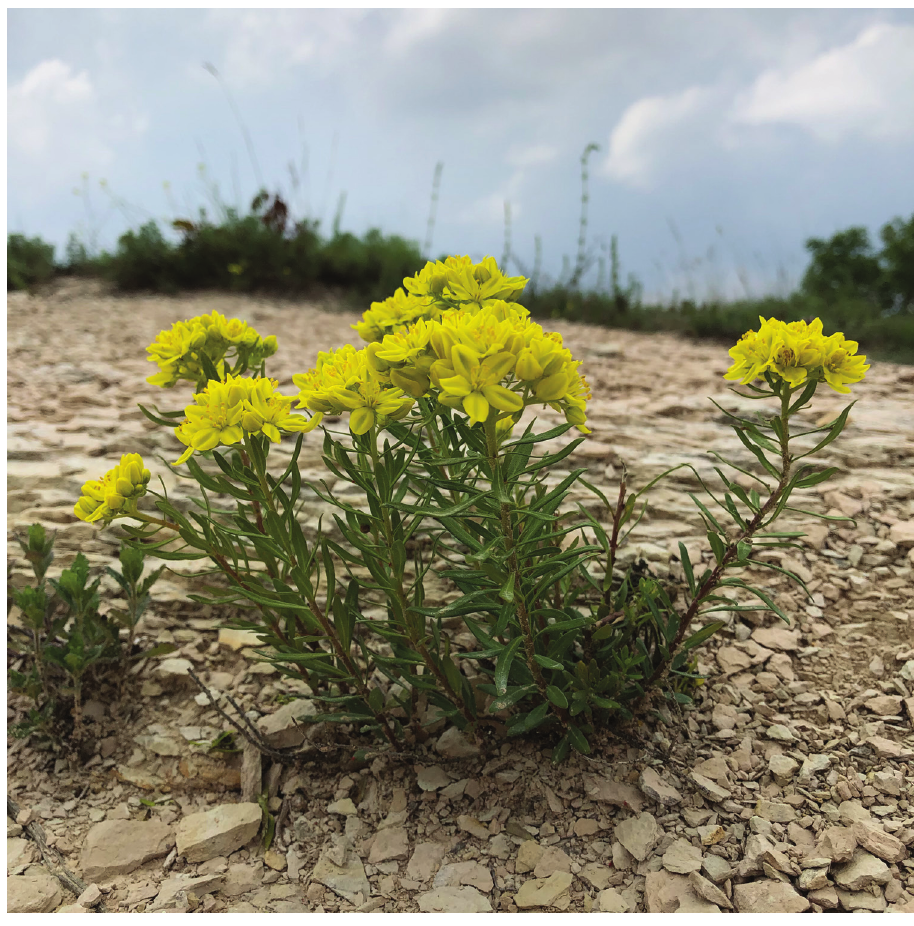
Figure 2. Haplophyllum patavinum (L.) G.Don in the Euganean Hills